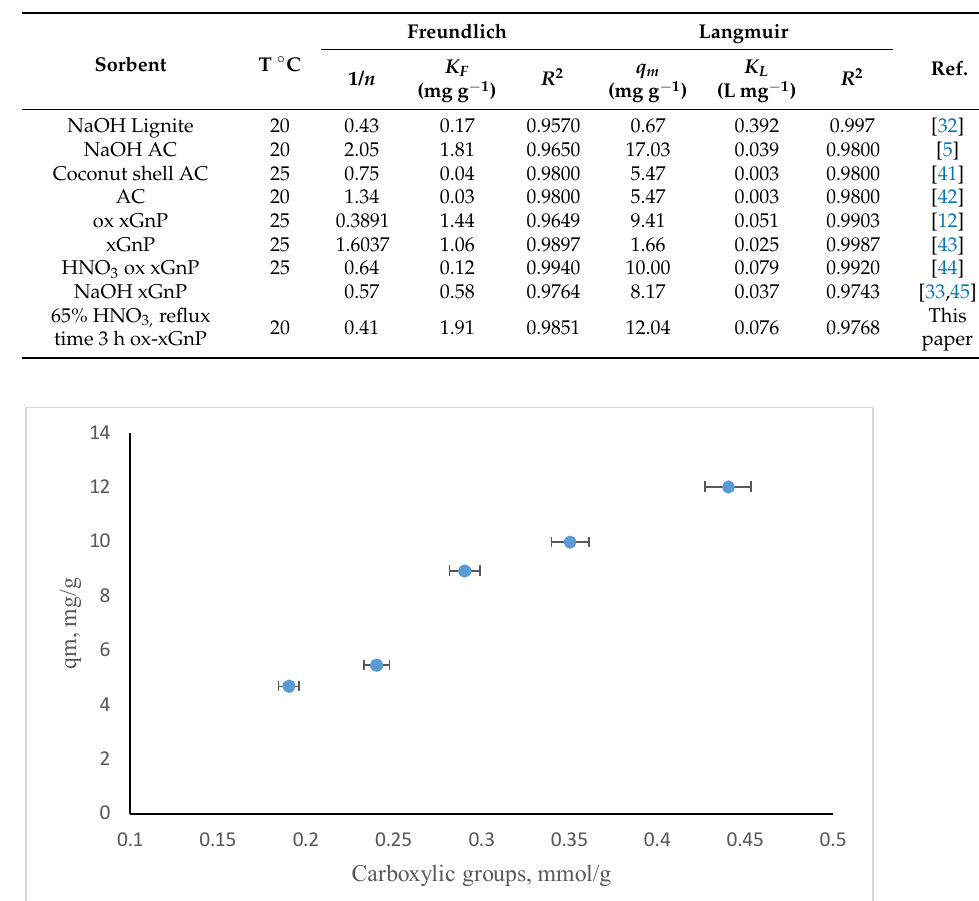
Figure 9. Correlation between the concentration of carboxylic groups at the surface of ox-xGnP and the adsorption capacity of the carbon sorbents.